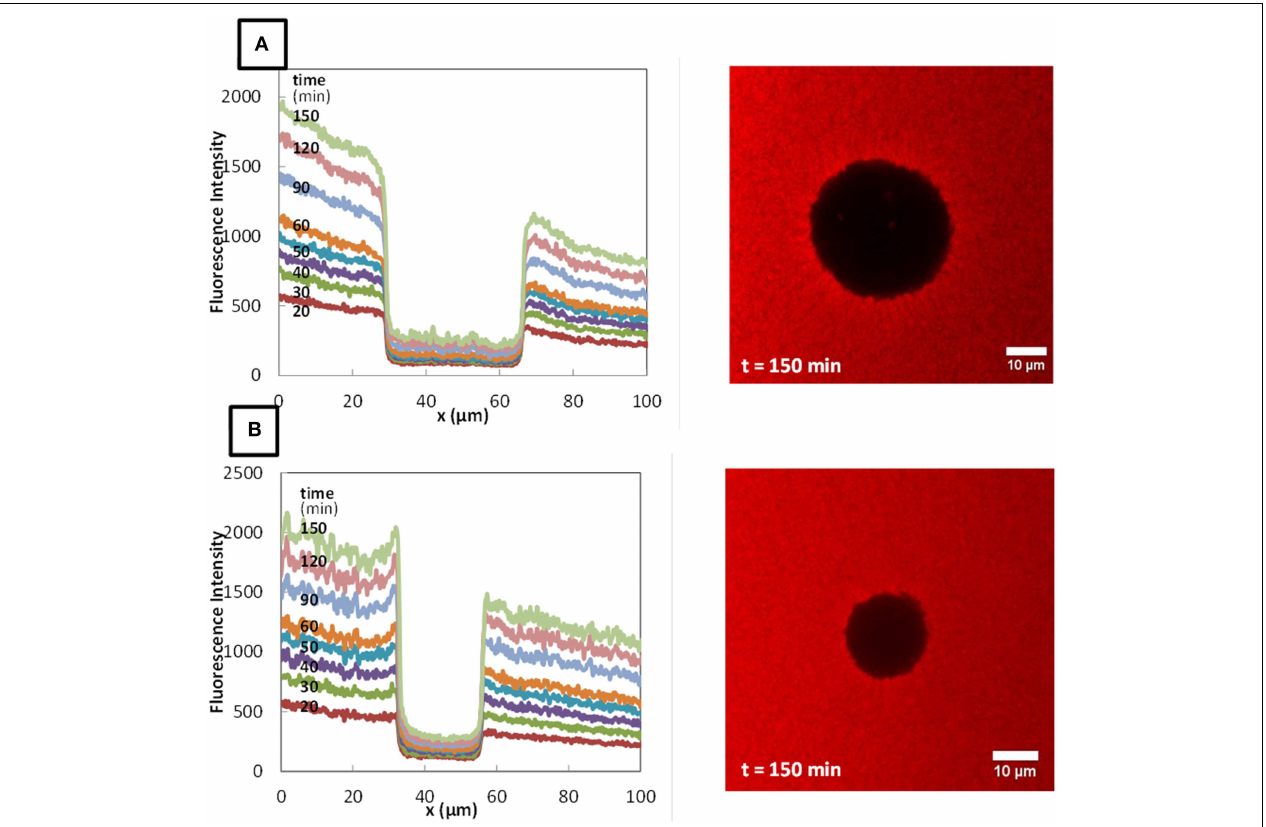
FIGURE 8 | Fluorescence profiles of RITC-LF in Lactococcus lactis LD61 (A) and TIL1230 (B) from 20 to 150min and corresponding microscopic observations of the colony after 150min of